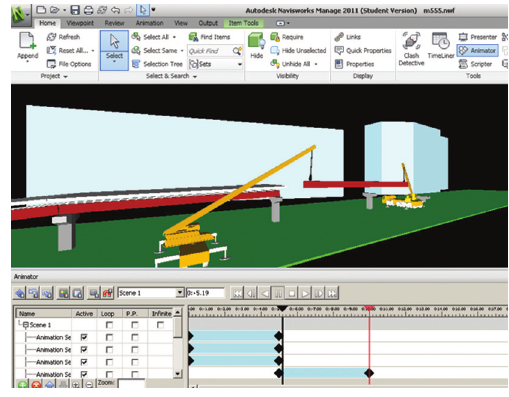
Fig. 11. Simulation and animation of beam erection in BrIM